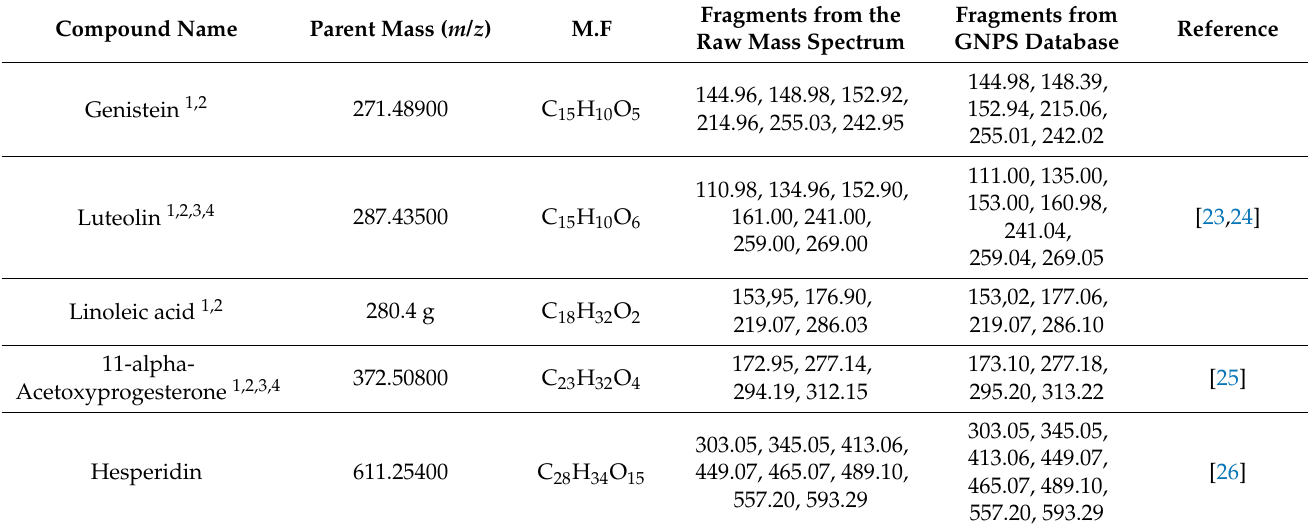
Table 1. The identified metabolites’ parent masses and fragments from the raw mass spectrum compared with that of the molecular networking database and data